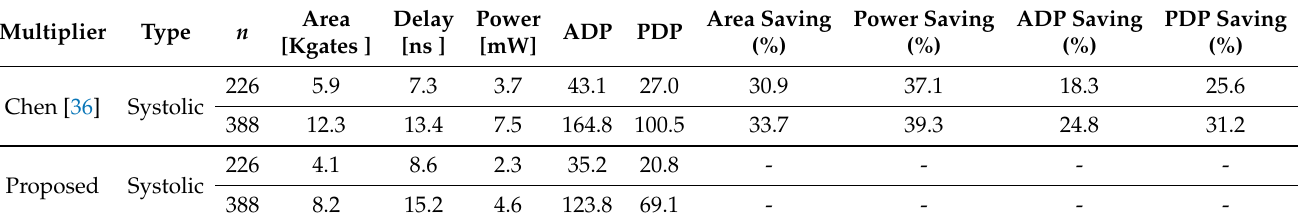
Table 2. Performance evaluation of various multiplier structures for n = 226 and n =